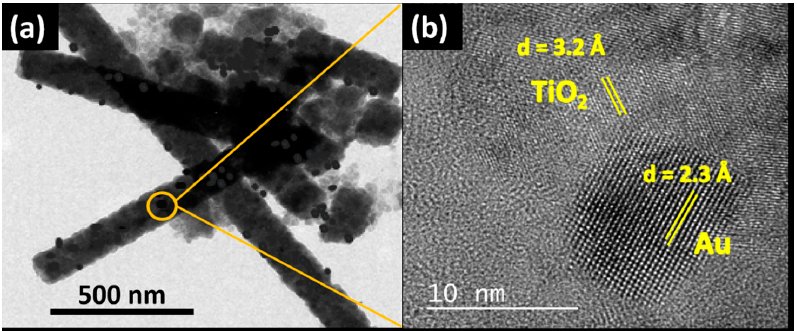
Figure 4. ( a ) Transmission ‐ electron ‐ microscopy (TEM) and ( b ) high ‐ resolution TEM (HR ‐ TEM) images of 15 ‐ Au/TiO 2 NF sample.